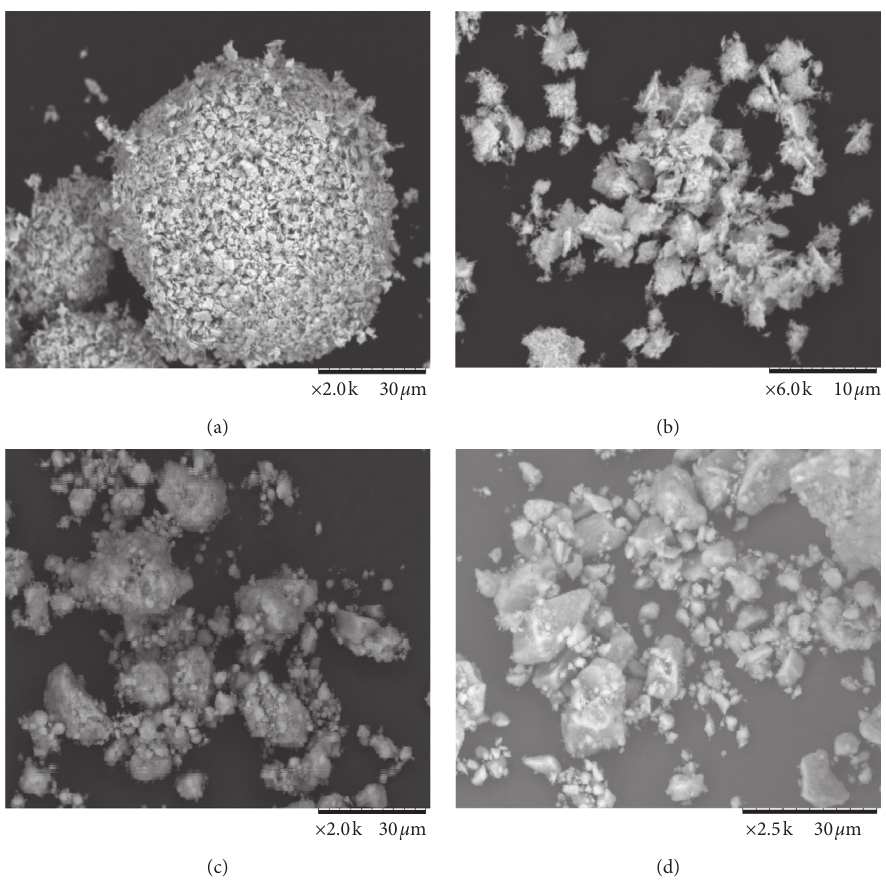
Figure 4: SEM images of the as elaborated samples: (a), (b) BiVO